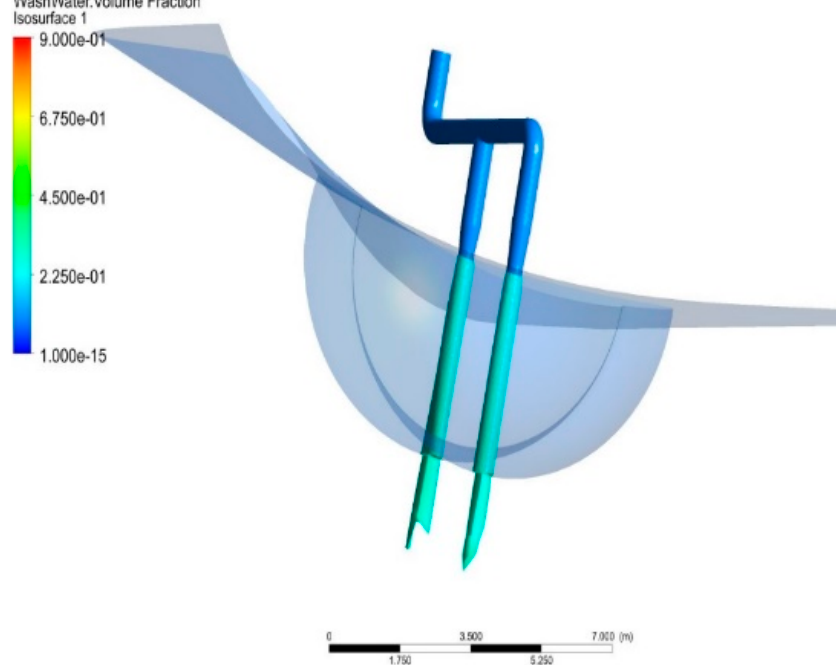
Figure 14. Scrubber Wash Water Volume Fraction of 0.2 isosurface development.